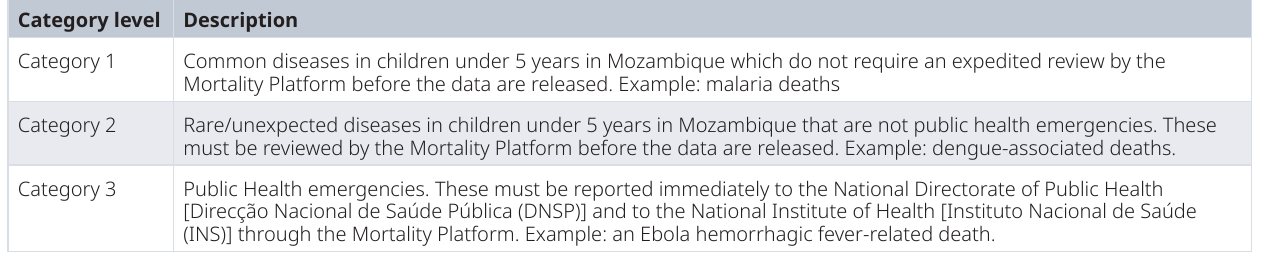
Table 3. Categorization of the cause of death results according to public health relevance, as fed into the Mortality Platform at the National Health Observatory of